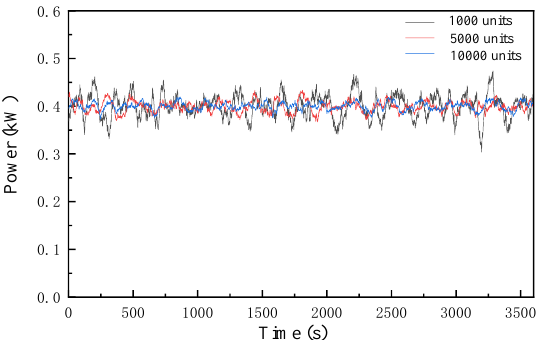
Figure 6. Total polymerization power of different polymerization quantities.